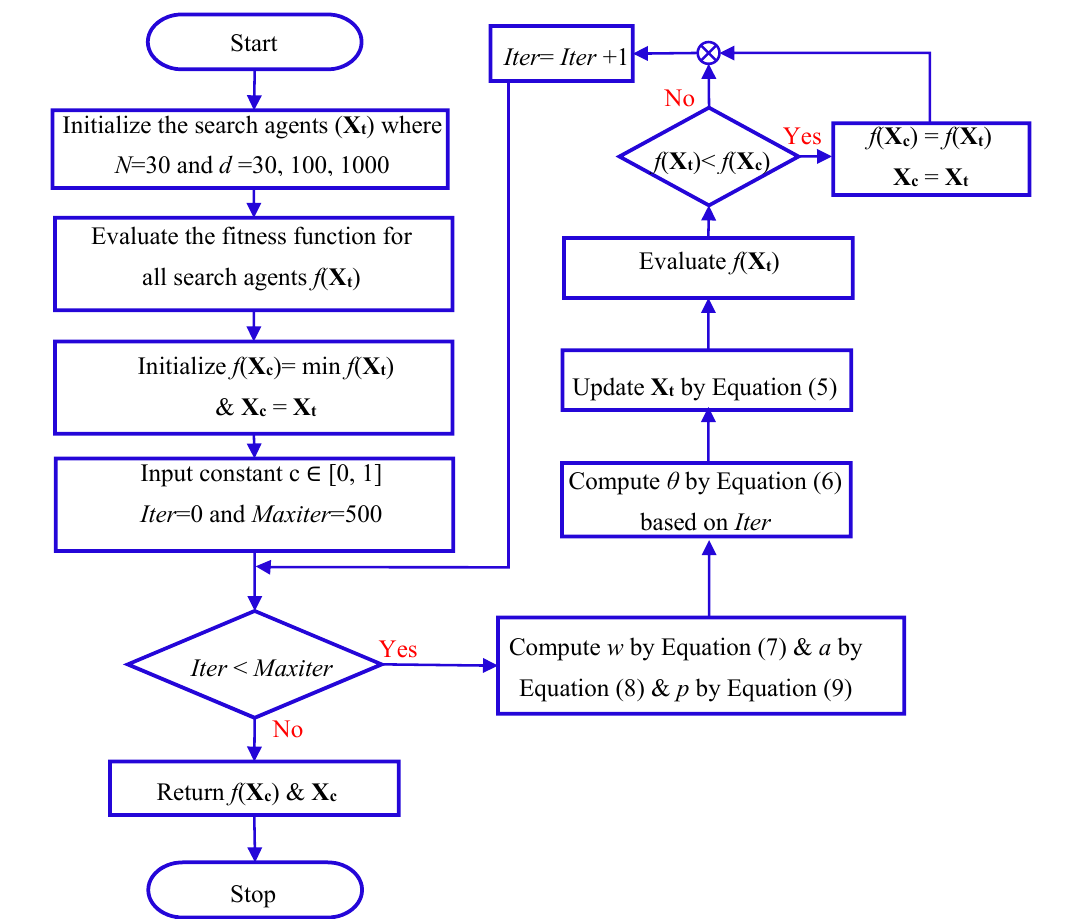
Figure 3. Flowchart of the CSA.